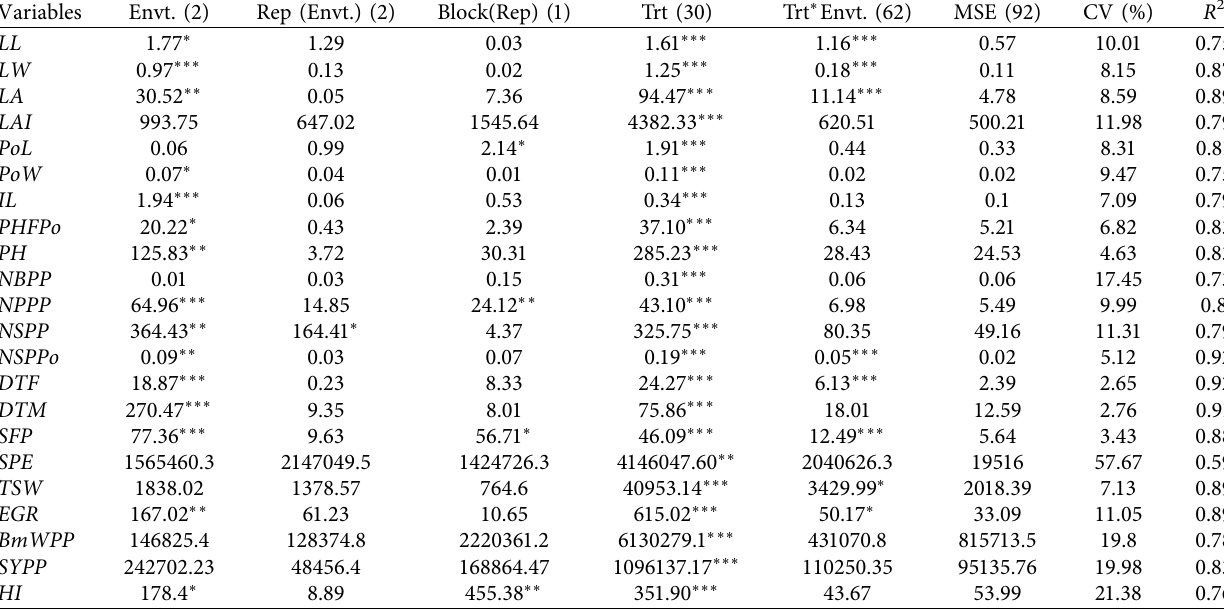
Table 7: Analysis of Variance (ANOVA) for the 22 quantitative traits evaluated using the 32 faba bean samples at the three test locations. Variables Envt. (2) Rep (Envt.) (2)